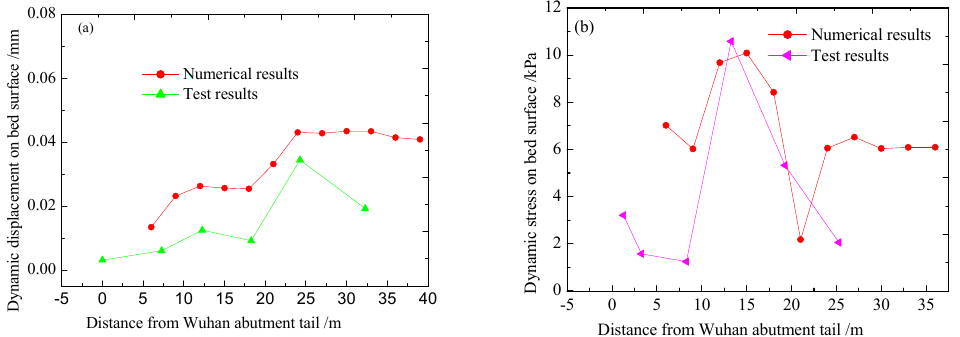
Figure 8. Comparison of measured and numerical results of dynamic stress amplitude on the surface of subgrade bed. ( a ) Dynamic displacement; ( b ) dynamic stress.